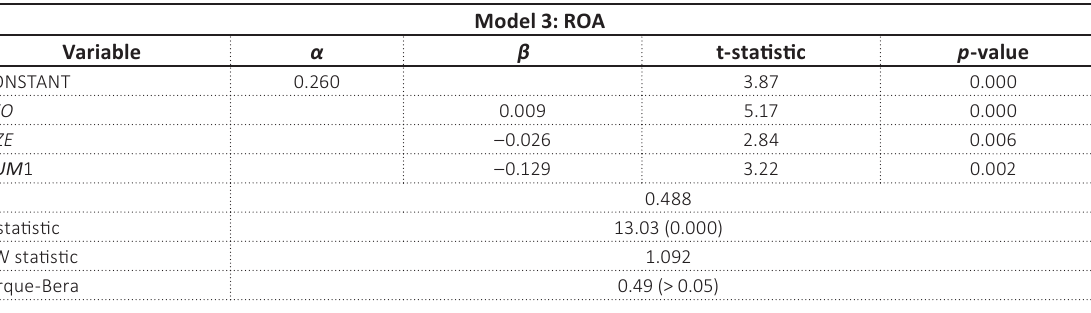
Table 5. Result of regression analysis